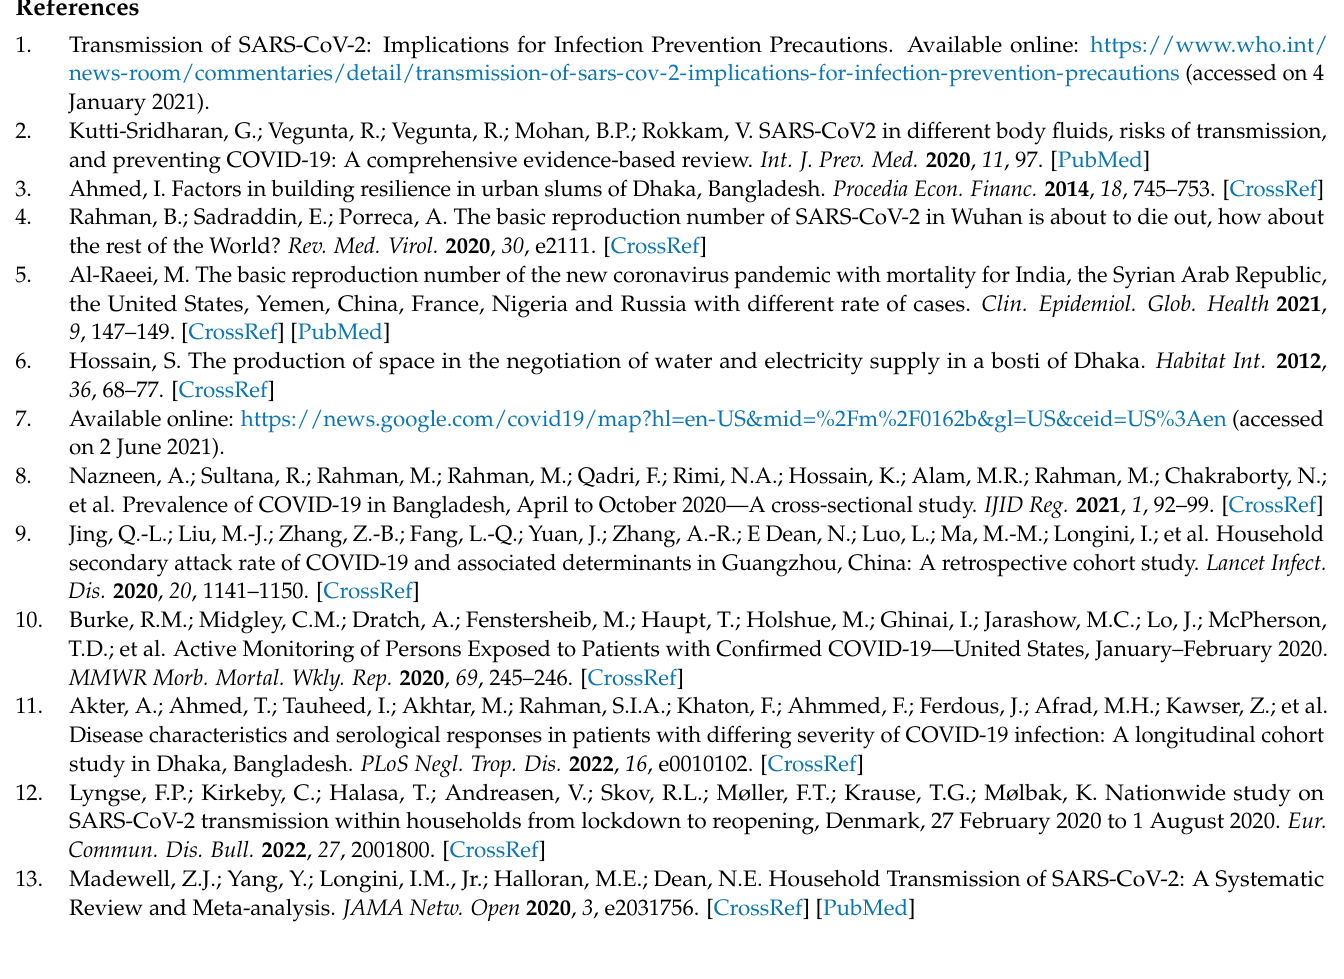
Figure A2. Diagram showing the setting of exposure and the direction of transmission from index case to household and neighborhood contacts in low-density areas in Dhaka city.